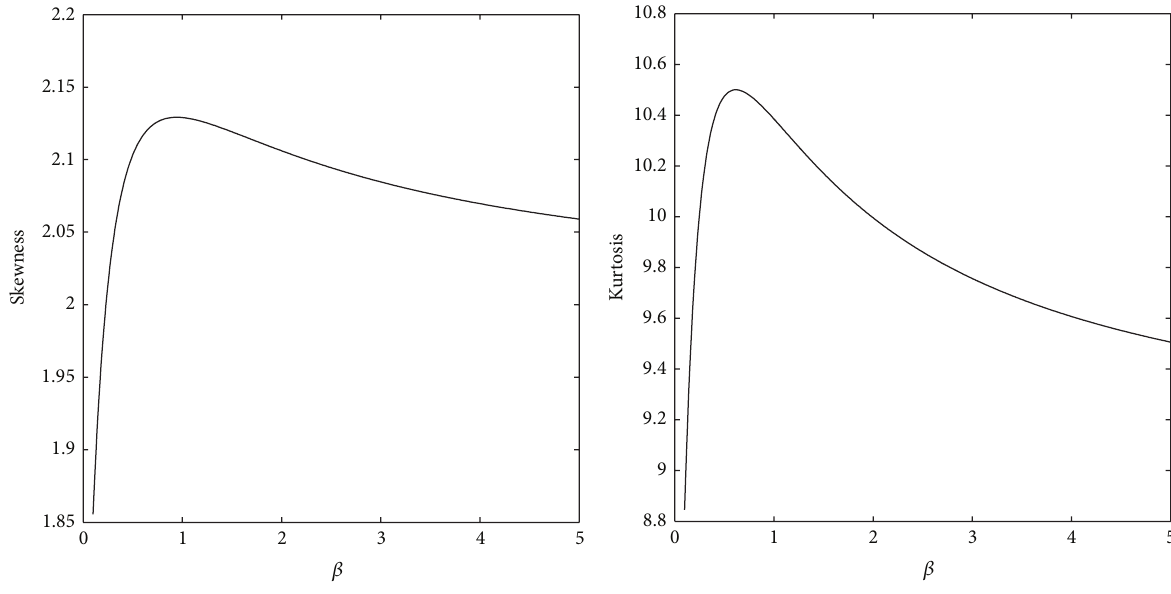
Figure 1: Skewness and kurtosis of 𝑁(𝛽) as functions 𝛽